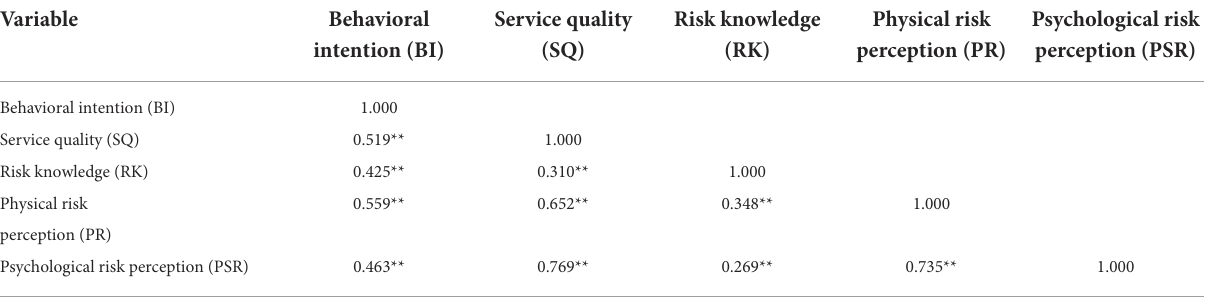
TABLE 4 Analysis correlation variable of the model of risk knowledge pathways to behavioral intention of air travel risk perception during COVID-19.